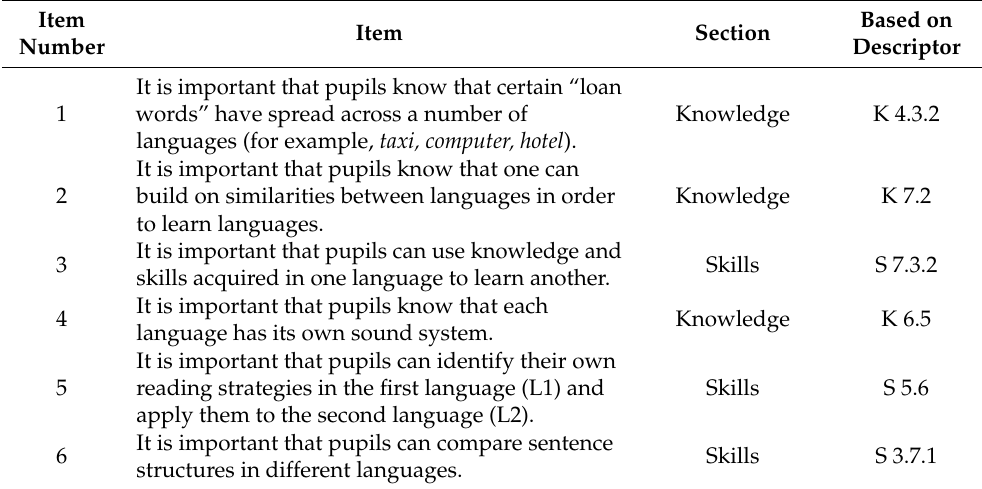
Table 5. FREPA-based items used in the present